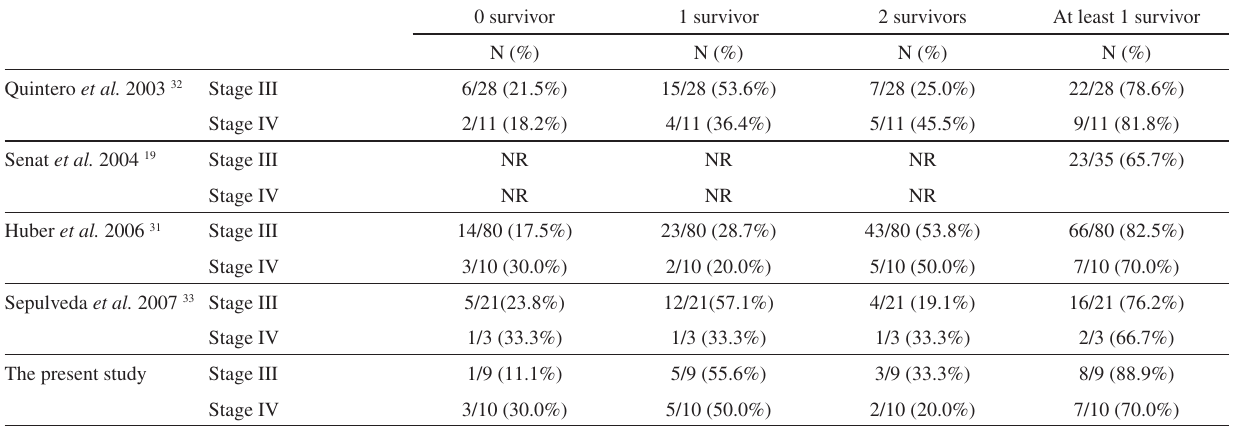
Table 2 - Comparison between our perinatal outcomes and those reported in the